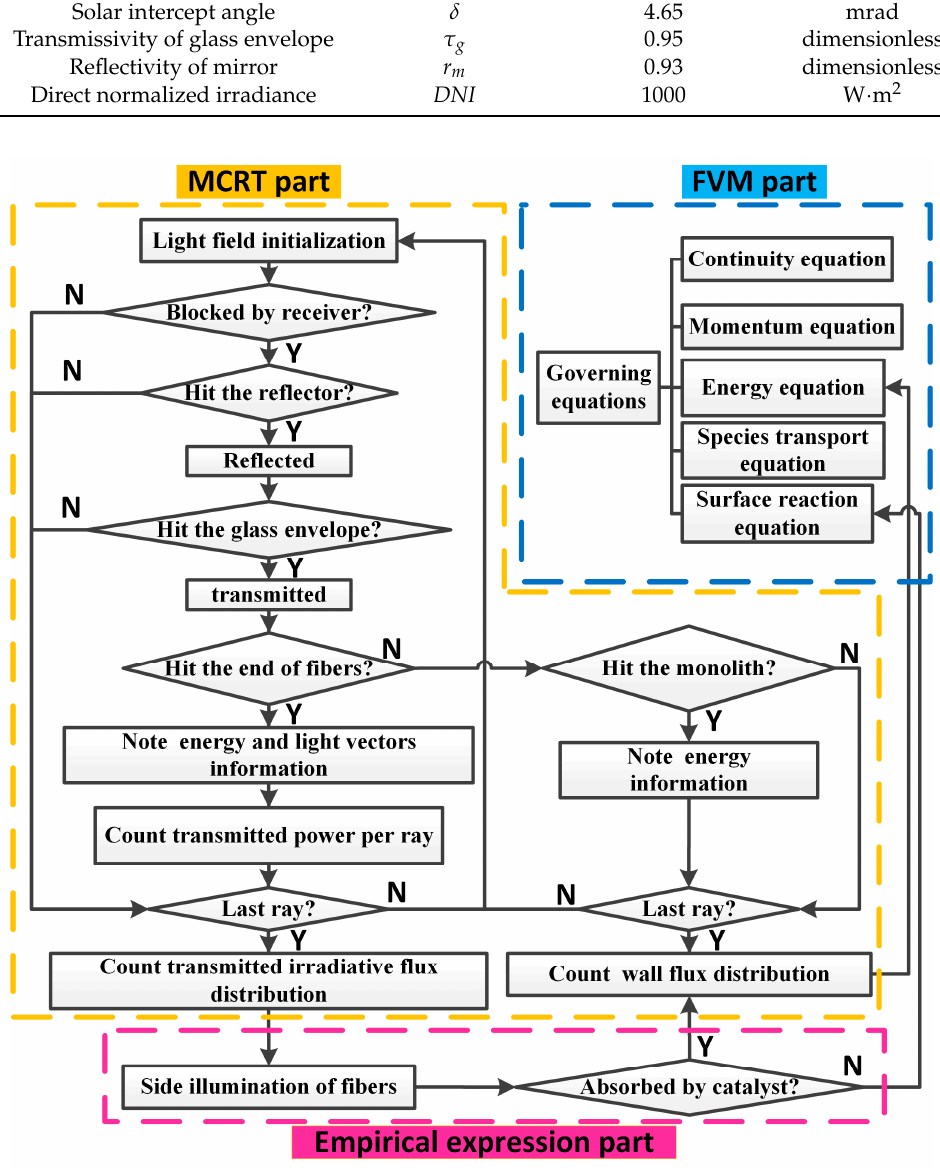
Figure 5. Block diagram of the computational model.